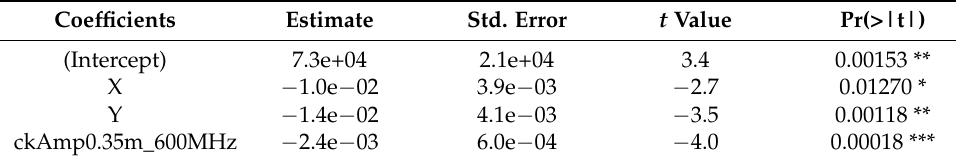
Table 6. The second linear model’s coefficients with related statistics.